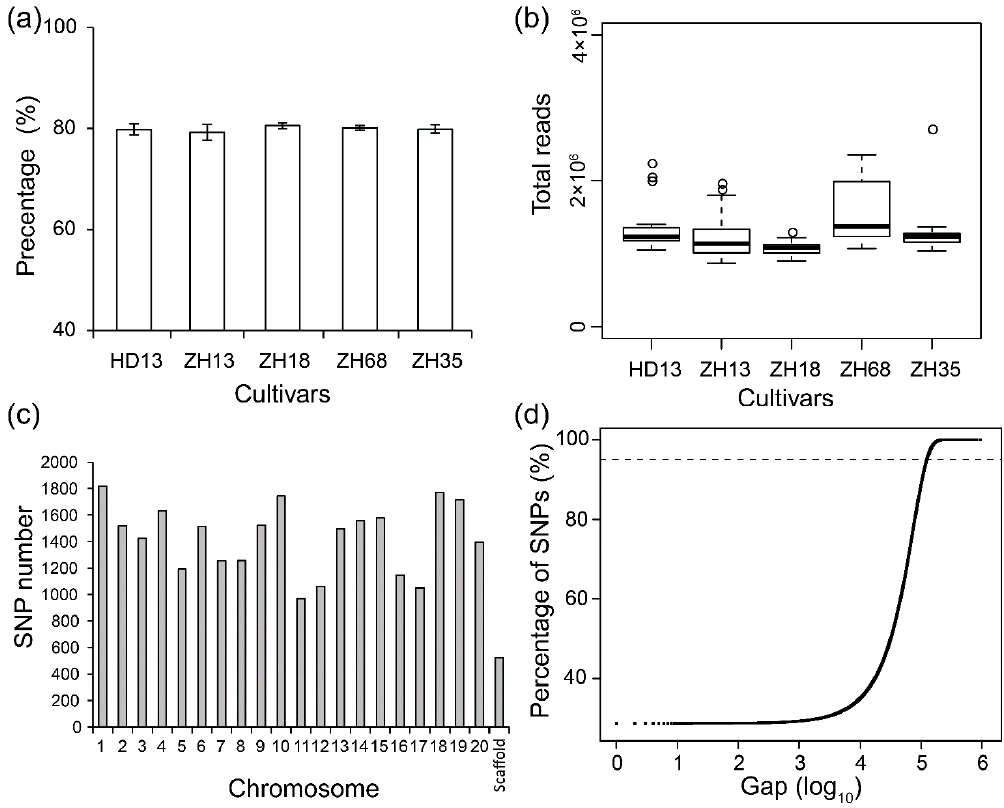
Figure 1. The basic information about specific-locus amplified fragment sequencing (SLAF-seq) results in five soybean cultivars. ( a ) The ratio of high-quality reads (QC30) in SLAF-seq for five soybean cultivars; ( b ) The total read number of SLAF-seq; ( c ) The single nucleotide polymorphism (SNP) number in individual chromosomes; ( d ) The distribution of the gaps between every two adjacent SNPs. The dashed line indicates the percentage of SNPs with gaps of less than 150